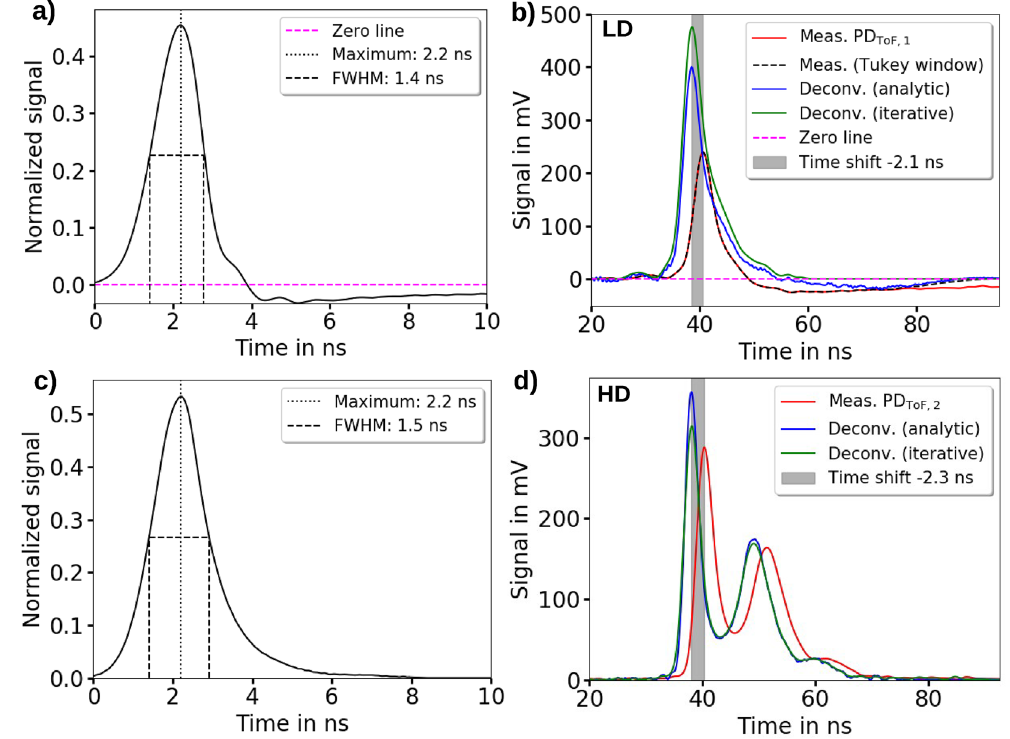
Figure 2. The time response functions of the time-of-flight (ToF) beam monitoring system (BMS) and the deconvolution of the measured ToF BMS signals. The measured time response functions are normalized to an area of 1 and are defined to have a time window of 2.2 ns between starting point and maximum signal height, leading to a time shift of 2.2 ns of the ToF BMS signal to shorter proton flight times after the deconvolution. ( a ) The ToF BMS time response function with the amplified photodiode detector PD ToF,1 used for the low dose per pulse (LD) measurements. ( b ) The analytical and iterative deconvolution of the ToF BMS signal for the LD measurements with the amplified photodiode detector PD ToF,1 . Since the measured signal shows a negative ending a Tukey window is multiplied to enable the analytical deconvolution. ( c ) The ToF BMS time response function with the non-amplified photodiode detector PD ToF,2 is used for the high dose per pulse (HD) measurements. ( d ) The analytical and iterative deconvolution of the ToF BMS signal for the HD